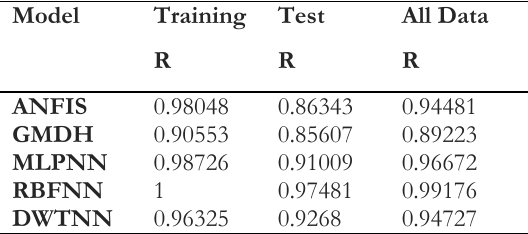
Table 3. Strength of the relationship between targets and